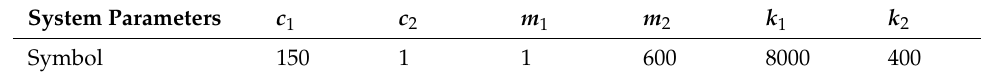
Table 2. The key parameters of the SOSMC